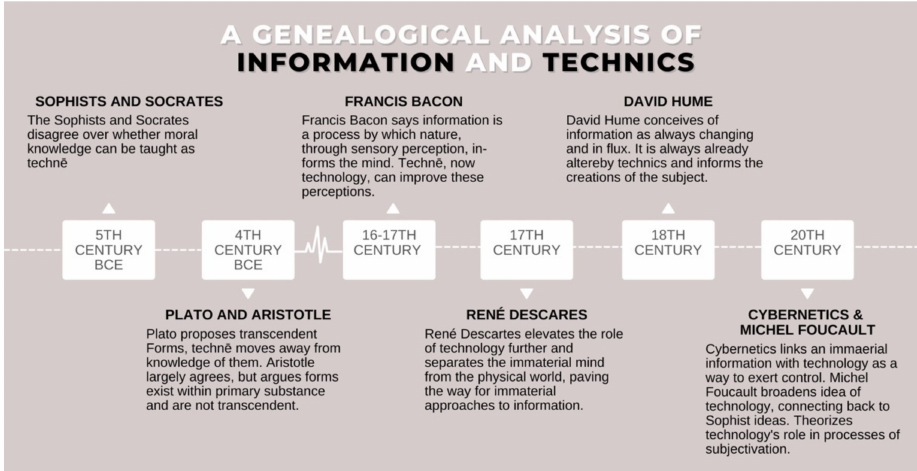
Figure 1. Overview of use of information and technics in major philosophic